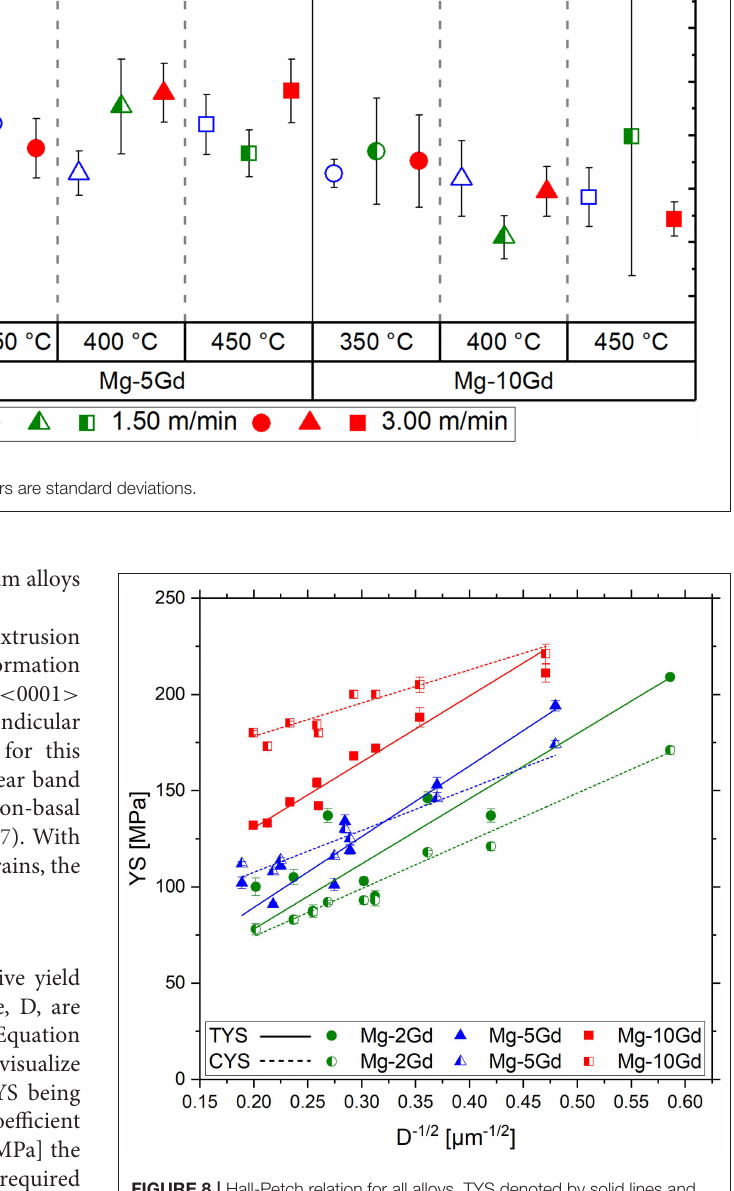
FIGURE 8 | Hall-Petch relation for all alloys. TYS denoted by solid lines and symbols. CYS denoted by halved symbols and dashed lines. Error bars are standard